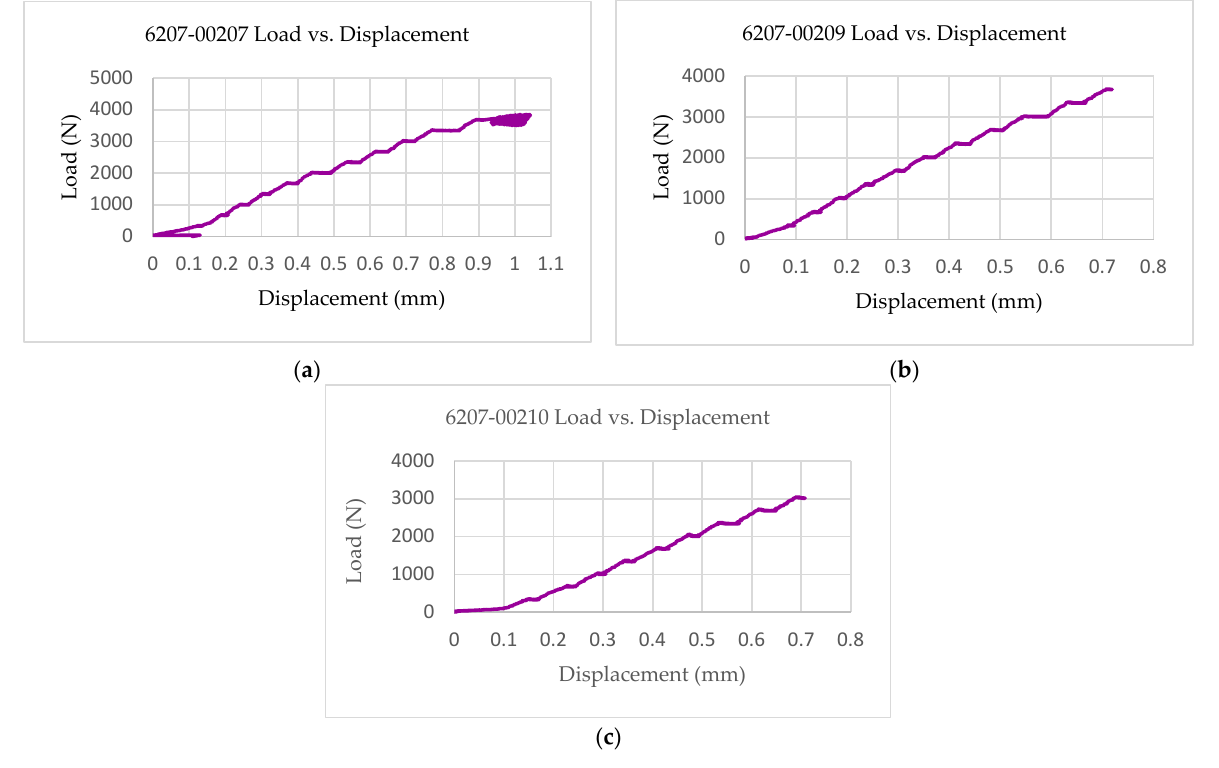
Figure 8. Load–displacement behavior of multifunctional test coupons at RTD: ( a ) 6207-00207; ( b ) 6207-00209; ( c ) 6207-00210.